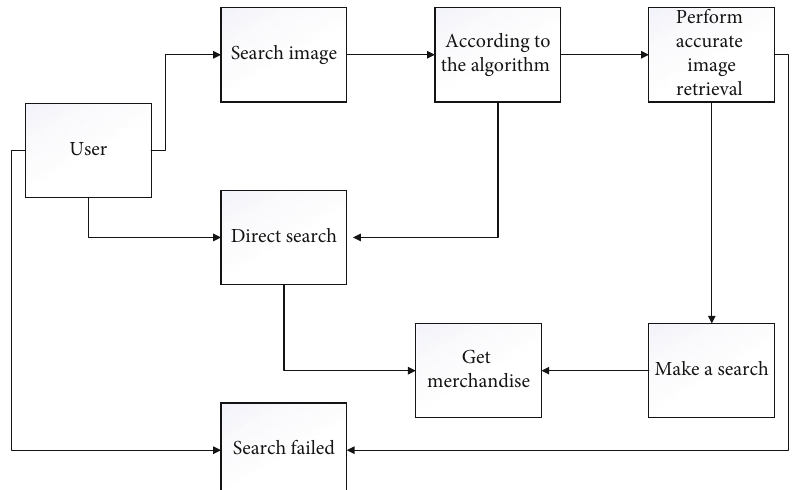
Figure 6: Model retrieval shopping product